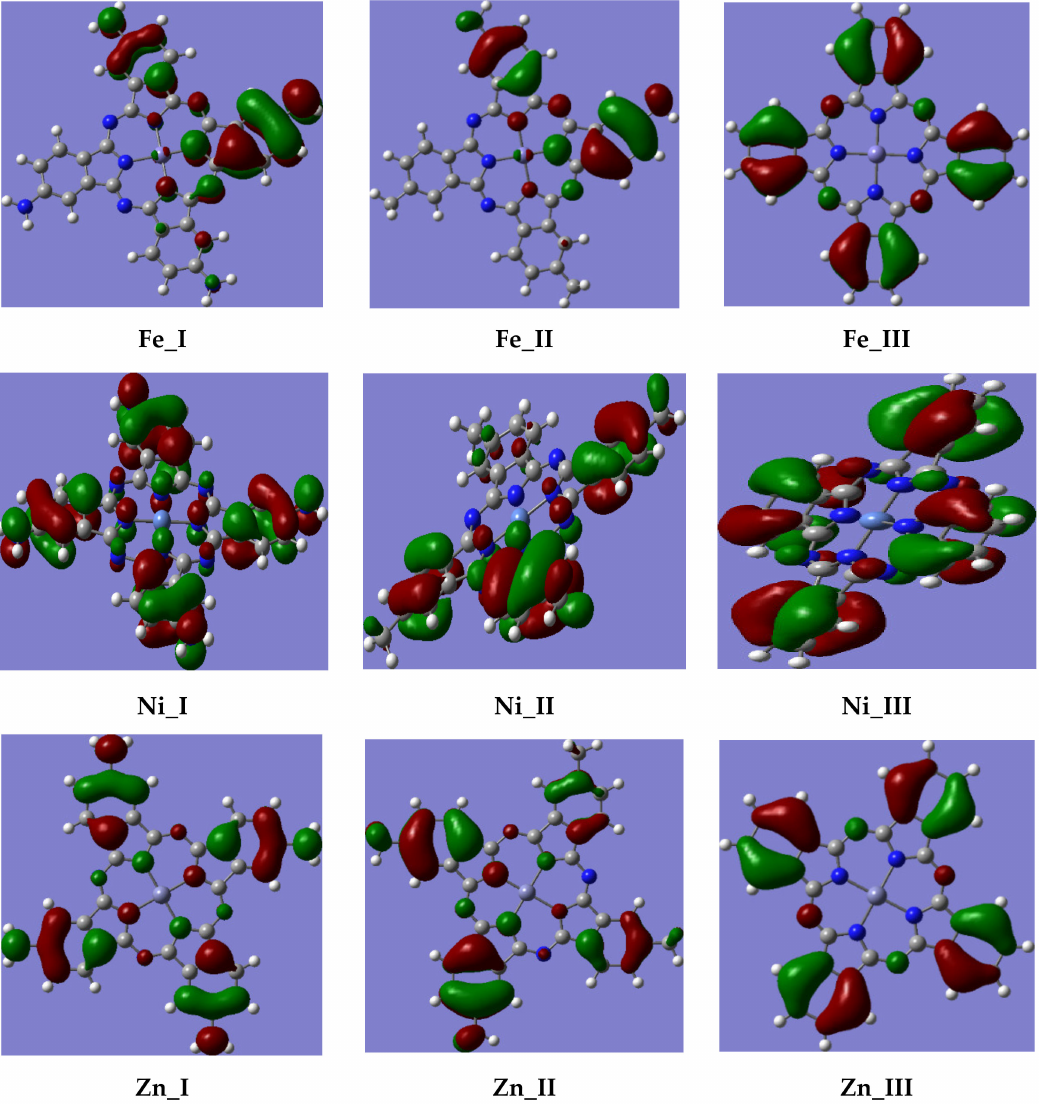
Figure 3. Graphical distribution of the HOMO orbitals of the